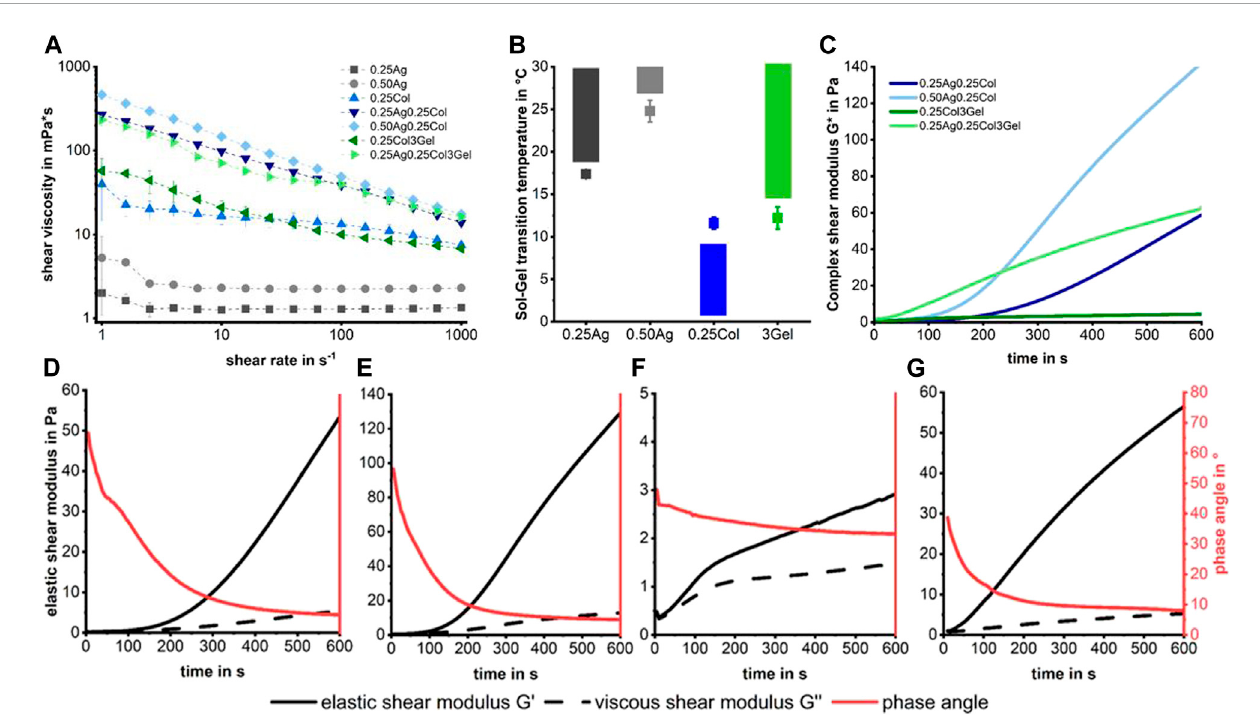
FIGURE 3 ShearviscositymeasurementsshowNewton-likebehaviorforagarosegels,whilecollagencontaininggelsarestronglyshearthinning (A) .Nofabrication window is visible in the sol-gel transition temperatures (B) , meaning that collagen starts to polymerize in a liquid matrix of agarose or gelatin, leading to an increasing shear modulus over time (C) . The gelation kinetics for each mixture of agarose/gelatin and collagen show an increasing modulus and reduced phase angle over time for 0.25Ag0.25Col at 20 ° C (D) , 0.50Ag0.25Col at 25 ° C (E) , 0.25Col3Gel at 20 ° C (F) and 0.25Ag0.25Col3Gel at 20 ° C (G) . n = 3 for (A,B) with standard